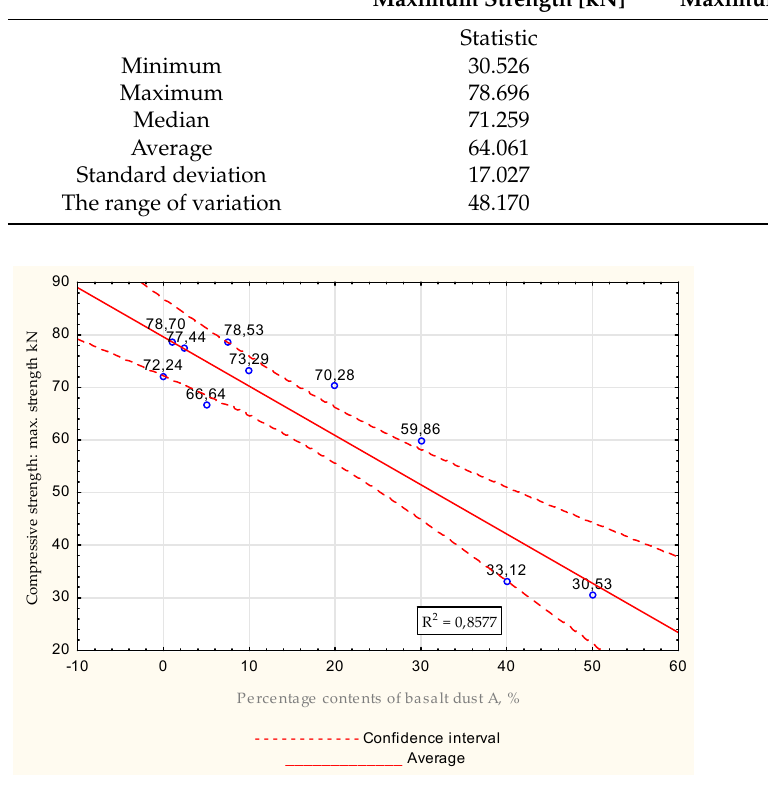
Figure 17. Average values received during compressive strength tests for water − mix ratio = 0.5, max. strength.